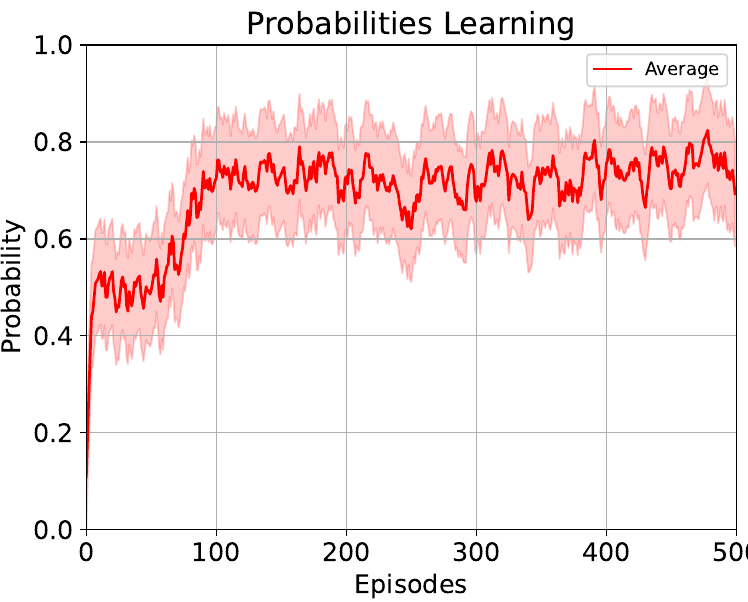
Figure 6. Average value of the probability of success for five runs of the agent’s training during 500 episodes using the learning-based method proposed in Algorithm 1. The probability value is smoothed and the shaded area refers to the standard deviation.